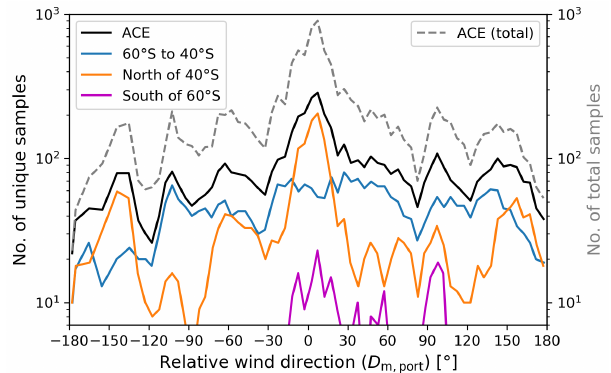
Figure 7. Number of “unique” observations per wind direction sec- tor for the same subsets as shown in Fig. 6. For the number of “unique” samples in each relative wind direction sector the multiple matches of the 5min data with the same latitude × longitude × time grid box of ERA-5 are counted only once. The grey dashed line (right axis) shows the total number of 5min samples. ACE (total) refers to the total “non-unique” counts.